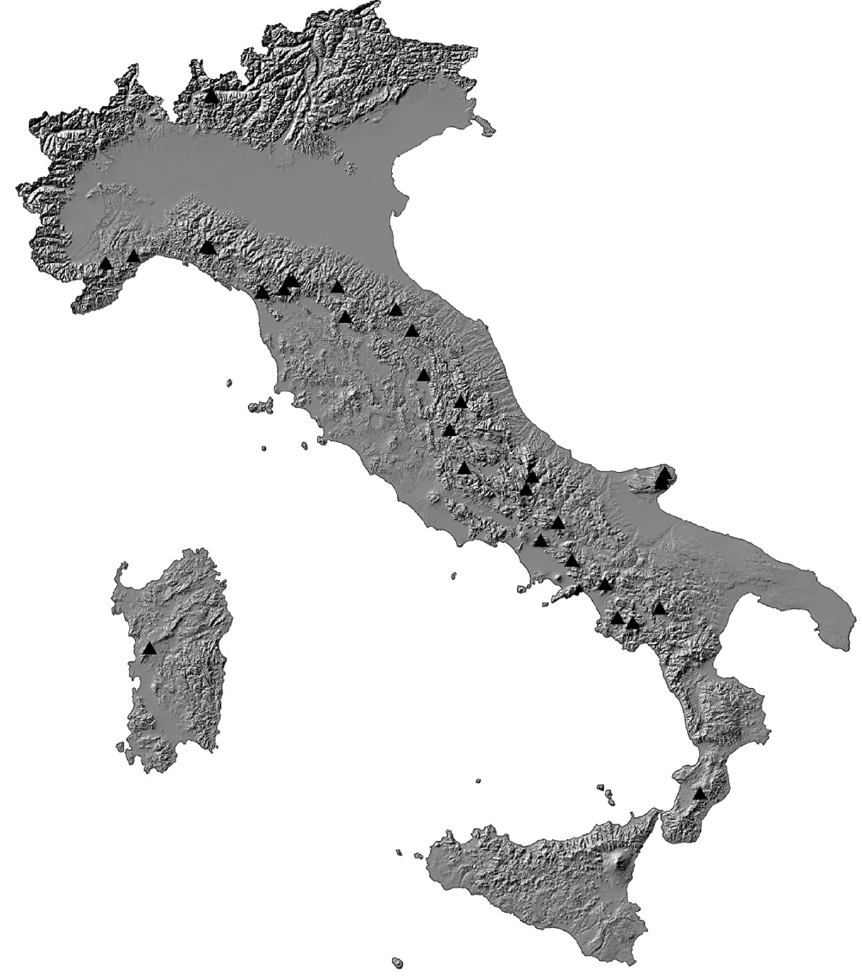
Figure 1. Location of the sampling points (black